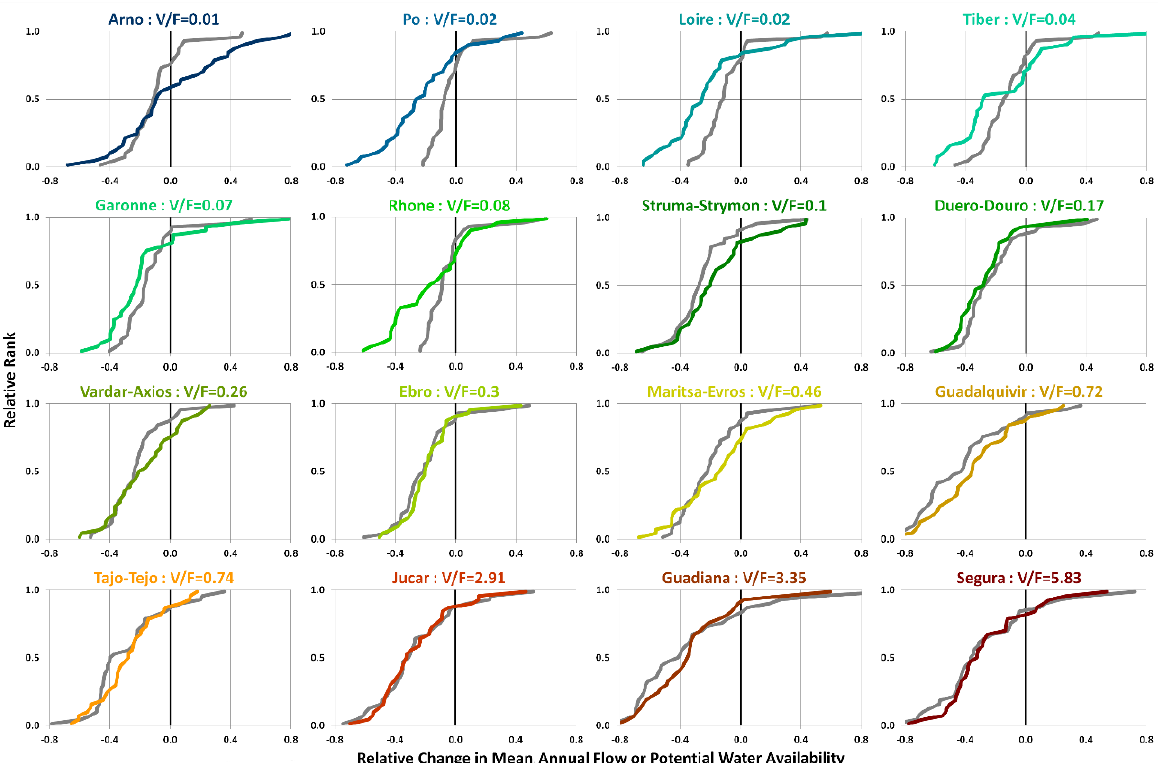
) and the estimated changes in Potential Water Availabil- , all projections; ( b ) Δ , mean Δ F F vs. PWA F vs.